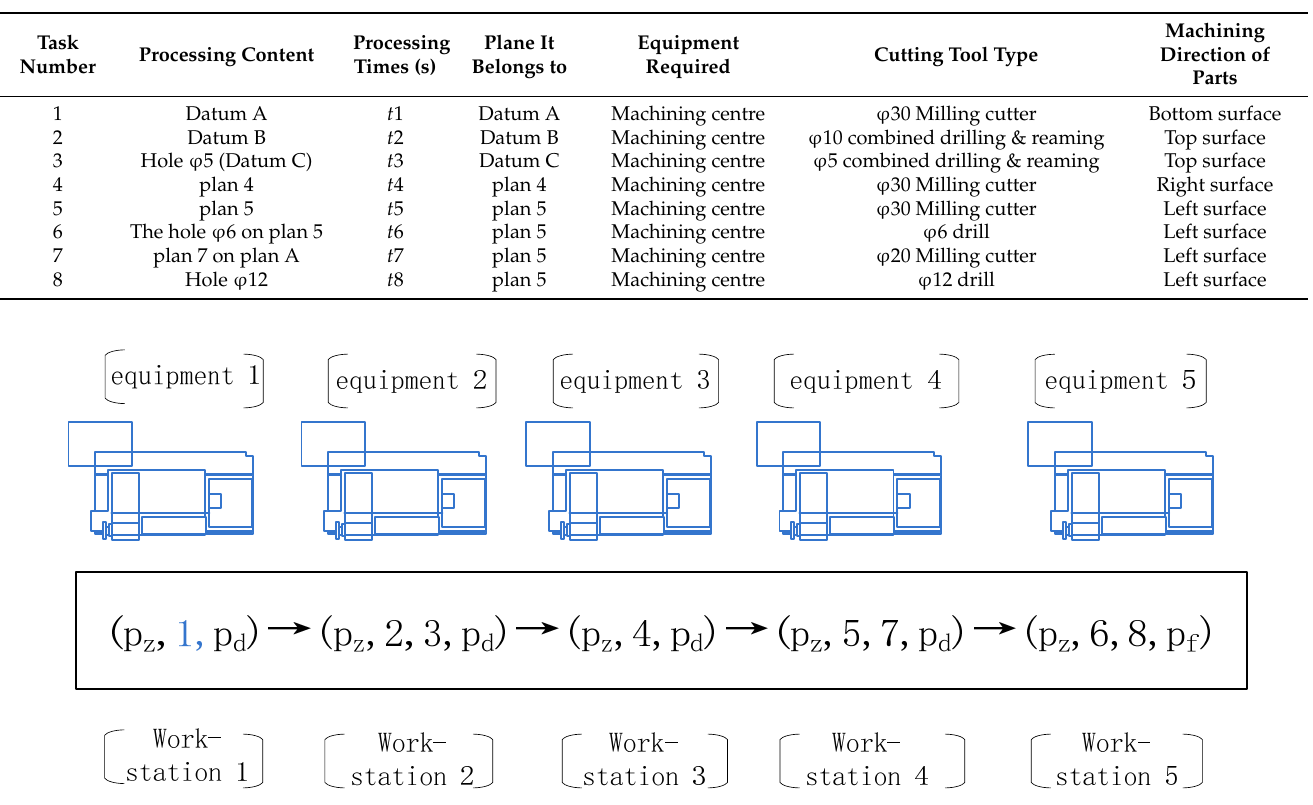
Table 1. Task operation procedure, time, operation direction, and tool requirement for the simple bracket part.